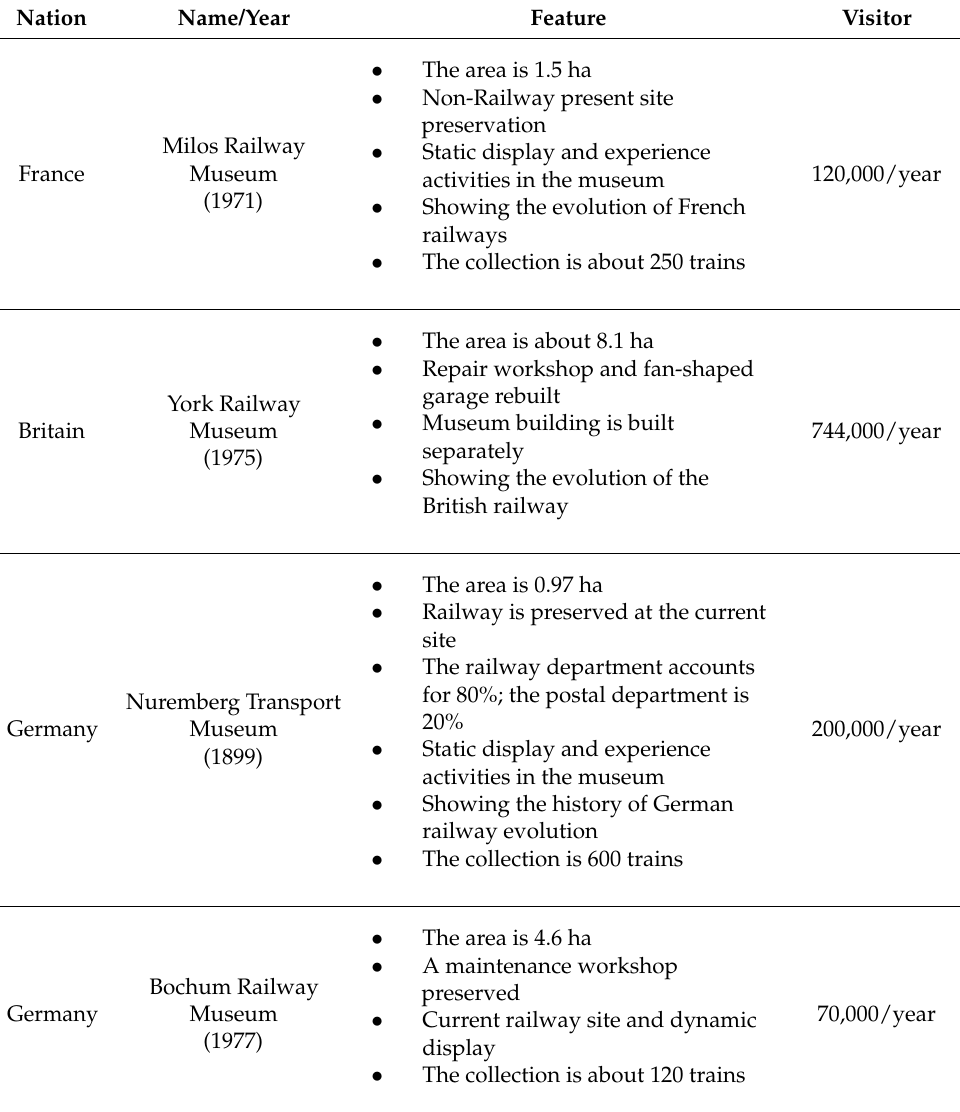
Table 2. Some national railway museums in the